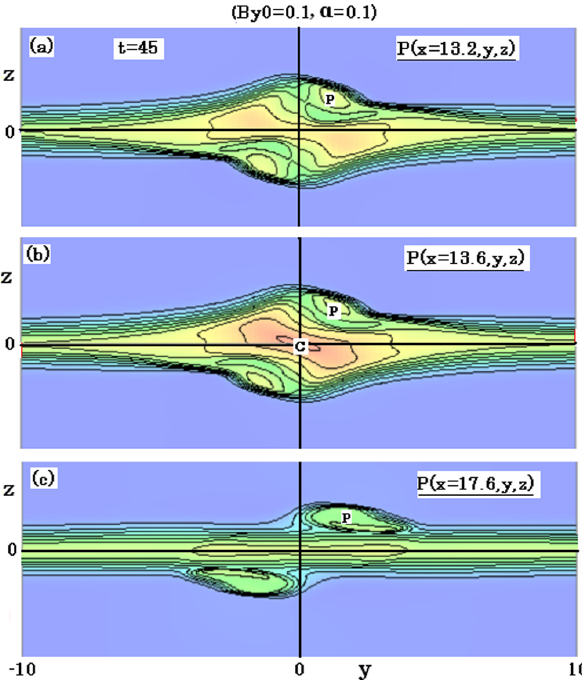
Fig. 8. Plasma pressure distributions (contour interval of 0 . 15) at t = 45 for the case of B y0 = 0 . 1 and α = 0 . 1 in the cross sections at (a) x = 13 . 2, (b) x = 13 . 6 and (c) x = 17 . 6, where the regions P and C are indicated.